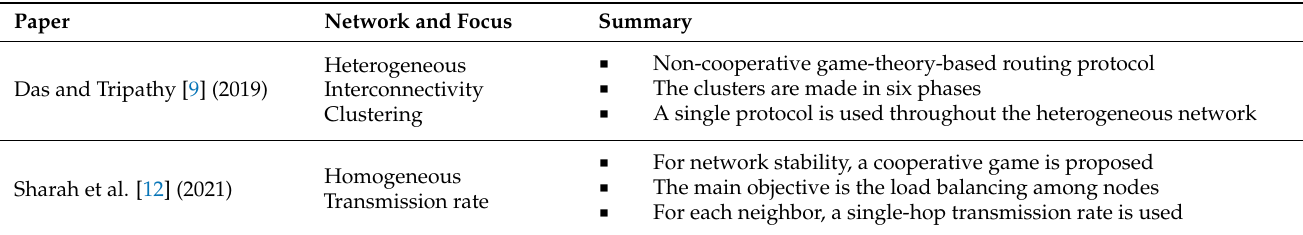
Table 1. Research papers focusing on game-theory-based routing.